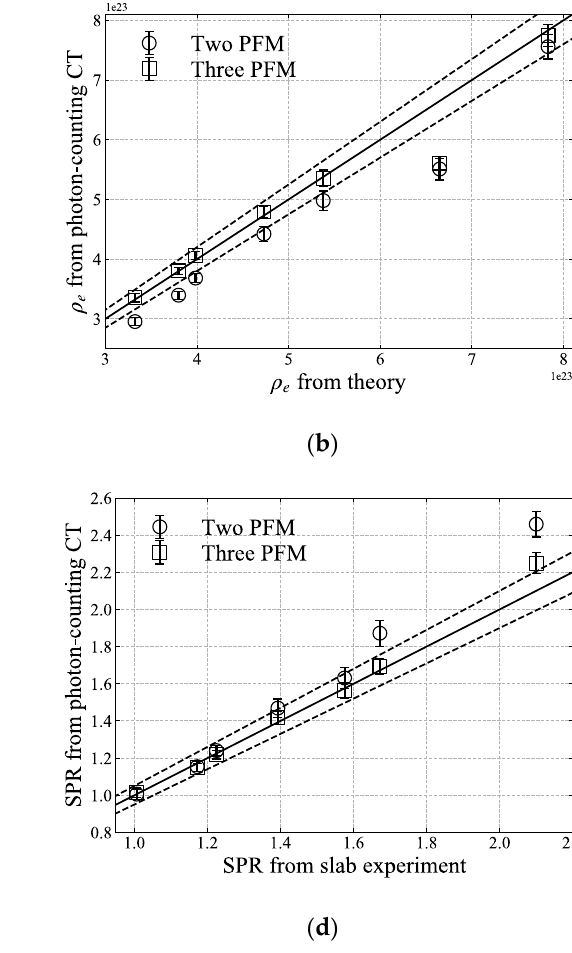
Figure 11. Comparison of ( a ) effective atomic number, ( b ) electron density, ( c ) I -value, and ( d ) SPR calculated via two-PFM and three-PFM with theoretical values. Solid lines indicate the same values for x- and y-axes, and the dotted line represents the error level of 5% for the solid line. Standard deviations are plotted together for each value. For the values here, regions of interest (ROIs) were set corresponding to the size of each rod sample in Figures 9 and 10, and the mean and standard deviation were calculated.